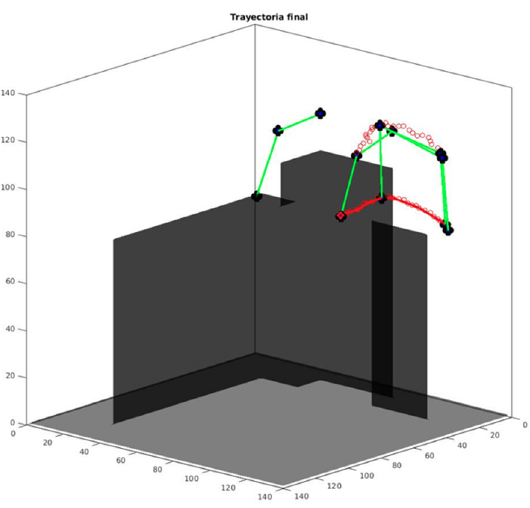
Figure 19. A generated trajectory. Red points are the paths calculated for the joints of the simplified